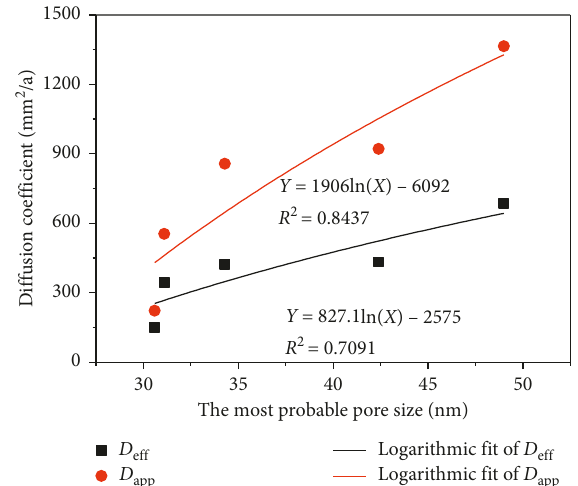
Figure 9: Relation between chloride diffusion coefficient and total porosity.